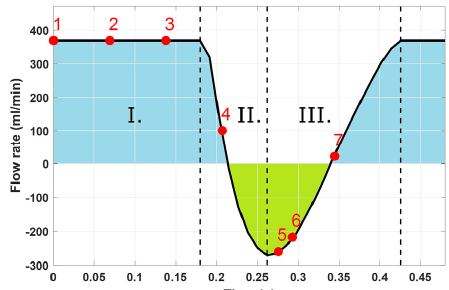
Figure 4. The pulse curve of the flow rate of the peristaltic pump in the extracorporeal circuit. The graph shows the volumetric flow rate pulse in the inlet of the peristaltic pump (arterial needle). The blue surface indicates the prograde velocity of the sucked blood, while the green surface represents the velocity of the flow reversal due to the peristaltic pump. The curve can be divided into three sections. Section I corresponds to constant suction. In Section II, the deceleration of the intake flow is starting to take place, and in Section III the intake flow starts to accelerate again. Red points represent the points of pulse at which the flow of blood was measured using the PIV method in selected measured areas. At point 2, the interaction between the intake flow and vein wall is the strongest.